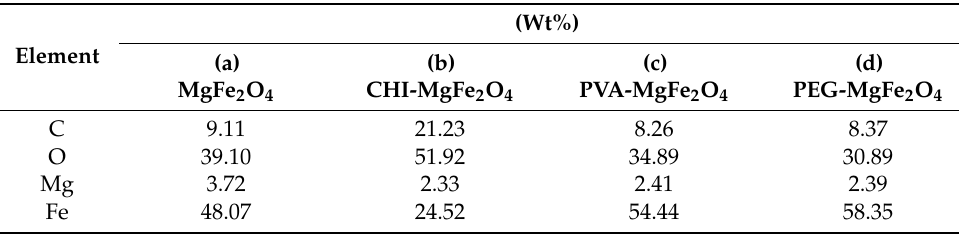
Table 3. Elemental composition of the (a) MgFe 2 O 4 , (b) CHI-MgFe 2 O 4 , (c) PVA-MgFe 2 O 4